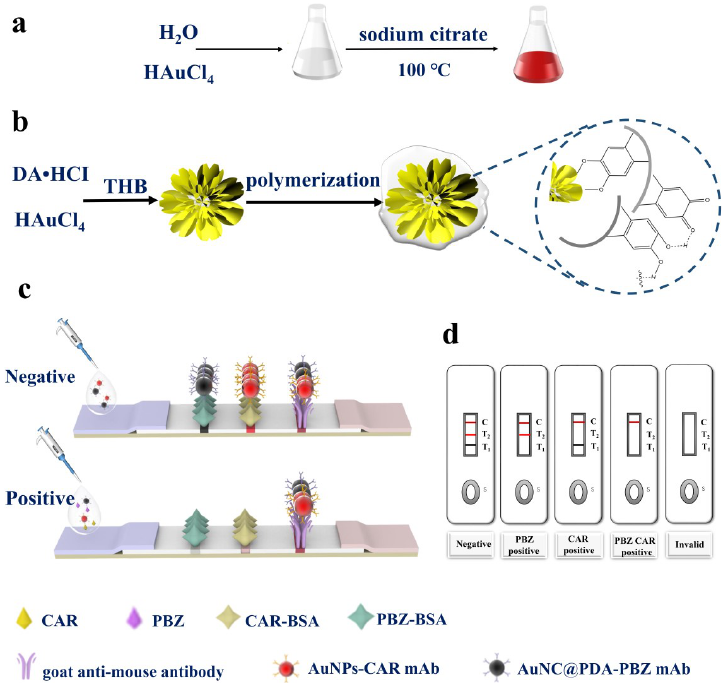
Scheme 1. Schematic illustration of the novel dual-color ICA based on AuNC@PDA and AuNPs for the detection of PBZ and CAR. ( a ) Synthesis of AuNPs. ( b ) One-pot synthesis of AuNC@PDA. ( c ) Principle of the novel dual-color ICA. ( d ) Interpretation of different test results. The black band on the T 1 line, red band on the T 2 line, and purple band on the C line represent negative samples; the red band on the T 2 line and purple band on the C line represent PBZ positive samples; the black band on the T 1 line and purple band on the C line represent CAR positive samples; the purple band on the C line represents PBZ and CAR positive samples; the absence of color bands on the T 1 line, T 2 line, and C line represents an invalid test strip.